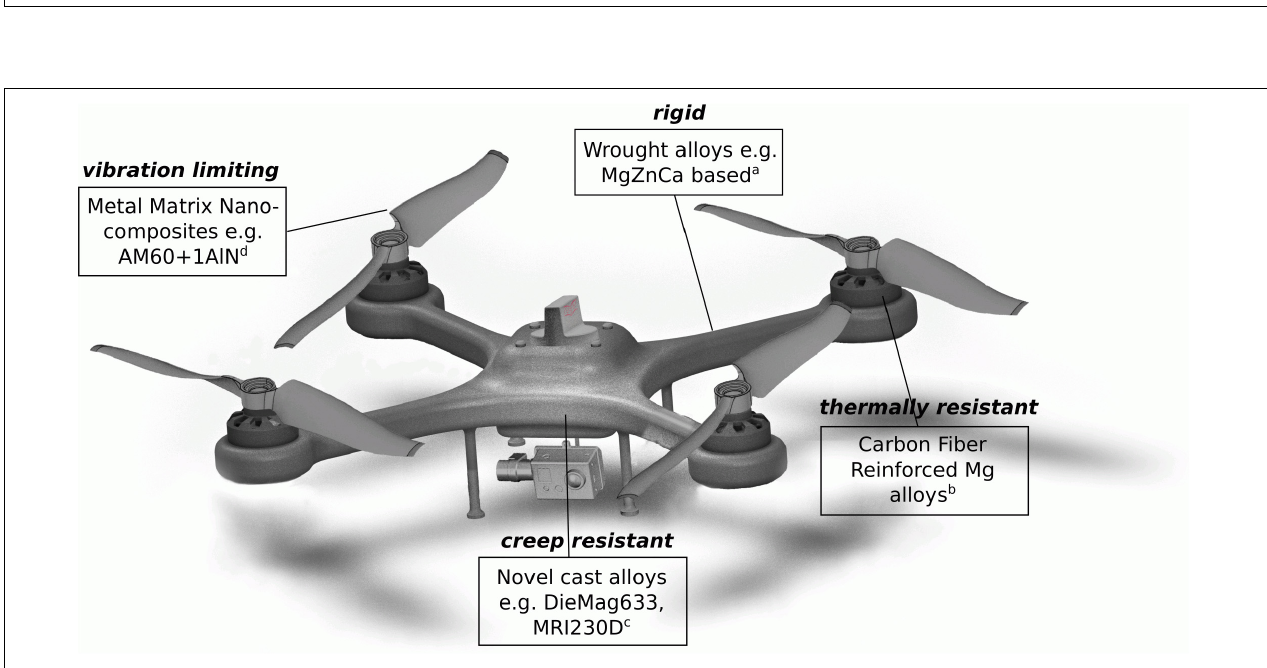
FIGURE 2 | Possible Mg-based alloys/hybrid materials for application in aerial vehicle construction like a quadcopter. Exemplified sources for further information about the materials are a: Naghdi et al. (2016), b: Dieringa et al. (2004), c: Gavras et al. (2019), d: Dieringa et al. (2017).